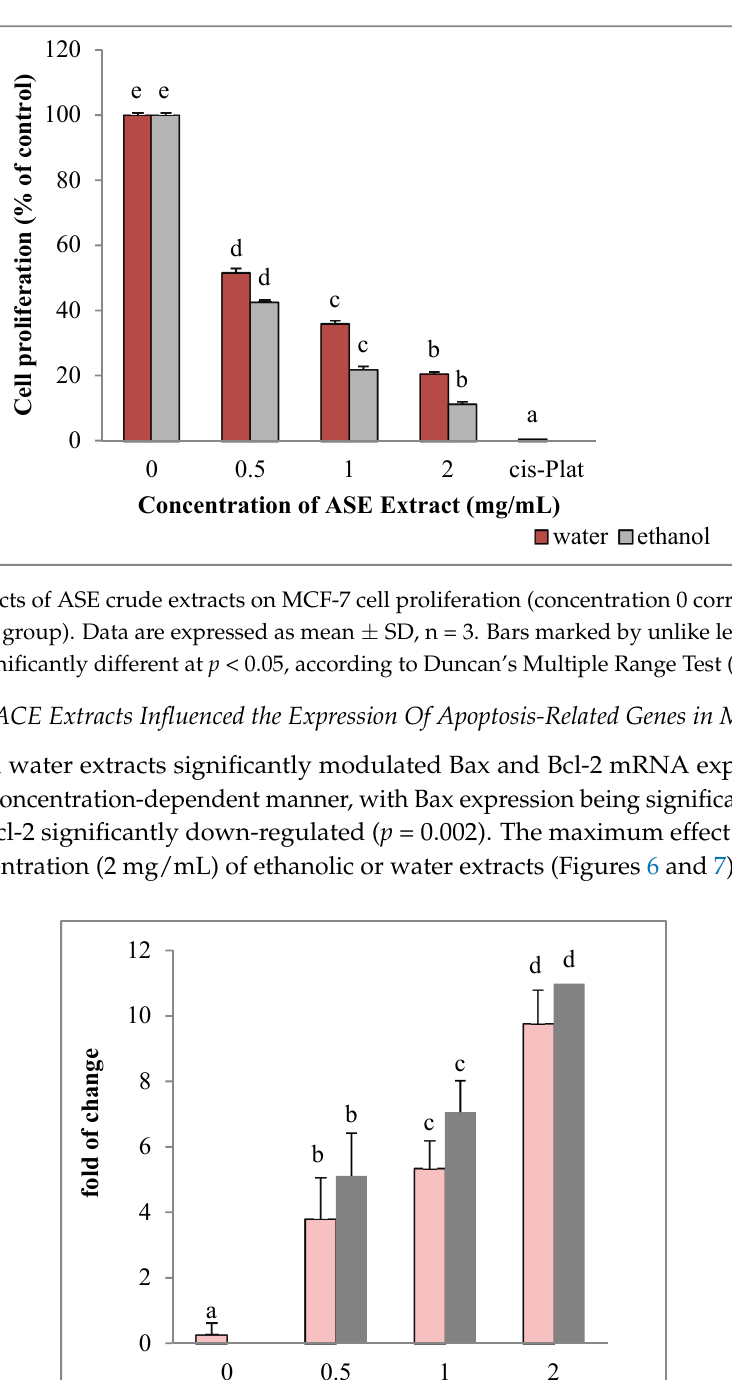
Figure 6. Effect of ASE crude extracts on Bax gene expression in MCF-7 cells. The mRNA levels are expressed as fold of change (2 − ∆∆ Ct ) as compared to untreated HepG2 cells (defined as 1) (mean ± SD; n = 3) and normalized to GAPDH. Bars marked by unlike letters within a group are significantly different at p < 0.05, according to Duncan’s Multiple Range Test